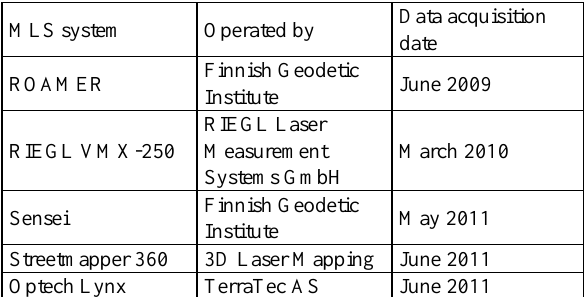
Table 1. Tested MLS-systems.